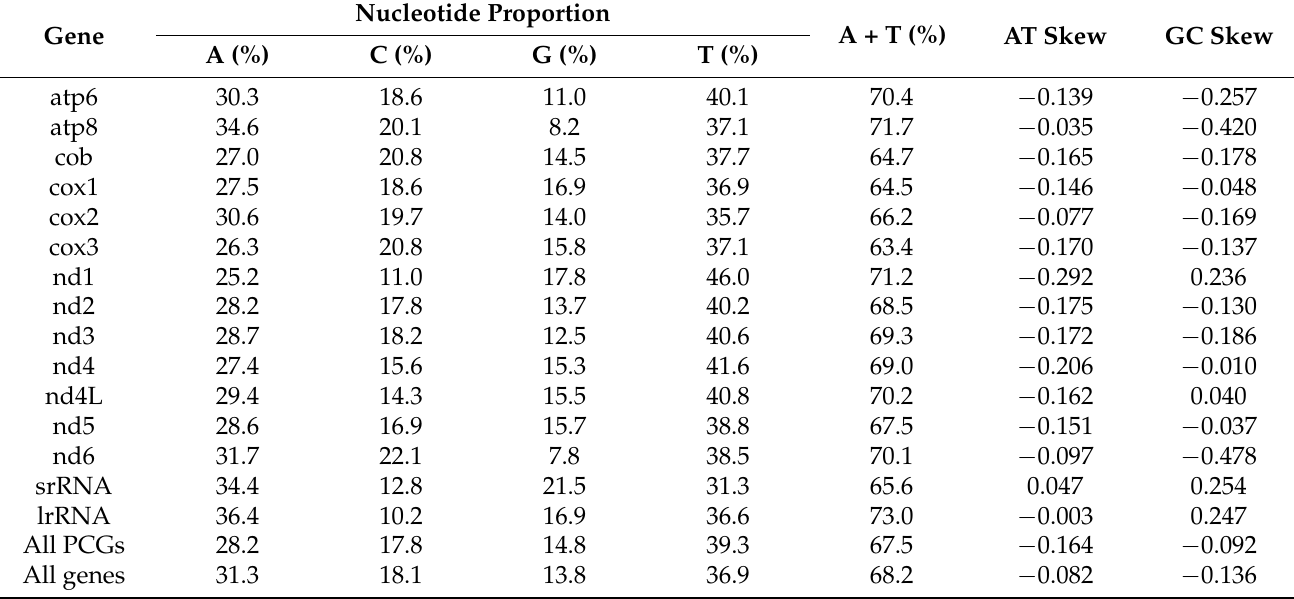
Table 3. Nucleotide composition and skew of M. coccopoma mitochondrial genes.